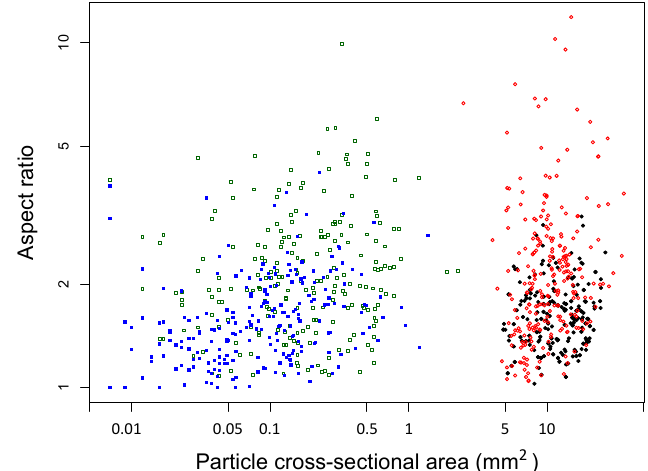
Figure 2. Particle aspect ratio (long/short axis length of fitted ellipse) vs. particle size (cross-sectional area) for biochars tested, based on image analysis. Symbols are as follows: closed squares (blue): S-ground; open squares (green): S-sieved; closed circles (black): L-ground; open circles (red): L-sieved.